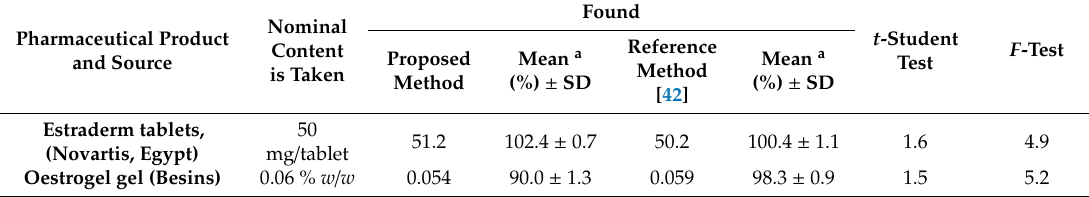
Table 3. EST determination in pharmaceutical preparations using EST membrane sensor.